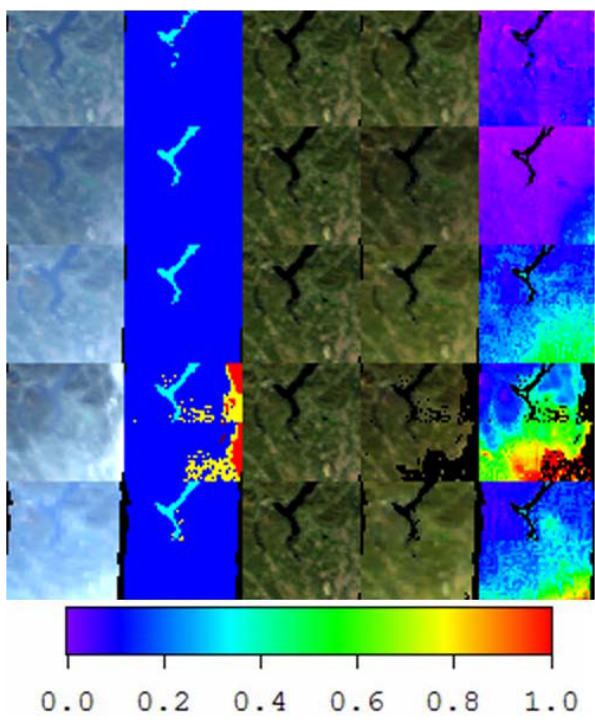
Fig. 4. Illustration of aerosol variability in 50km area near Ispra during 13–17 October 2001. The five columns show the MODIS Terra TOA data and MAIAC products including cloud mask, RGB NBRF (bidirectional reflectance computed from the BRDF model for a fixed view geometry of nadir view and 45 ◦ solar zenith angle), BRF (or surface reflectance) and AOT 0 . 47 . The blue and light blue colors of the cloud mask indicate clear over the land and water, respectively, and red-yellow show detected clouds.